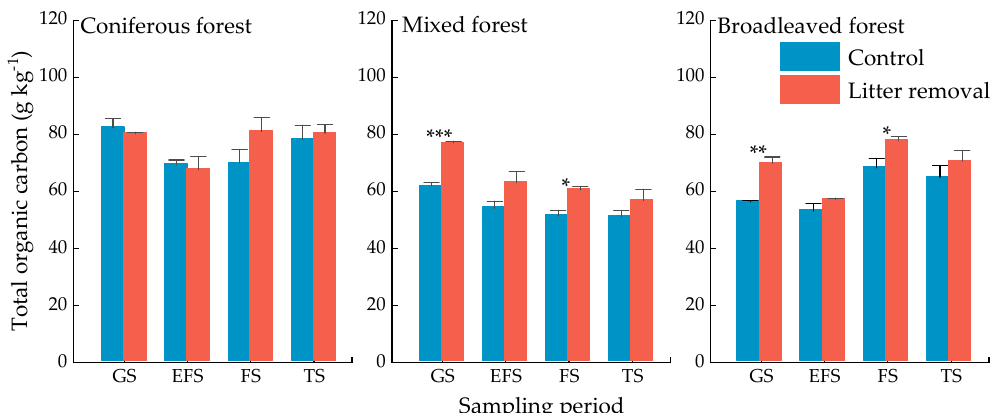
Figure 5. Concentrations of soil total organic C of three forests at different sampling periods. Values indicate means ± standard error, n = 3. GS: growing season, EFS: early freezing season, FS: freezing season, TS: thawing season. Asterisks indicate significant differences between the two treatments in same forest type in the same season. * p < 0.05, ** p < 0.01, *** p < 0.001.